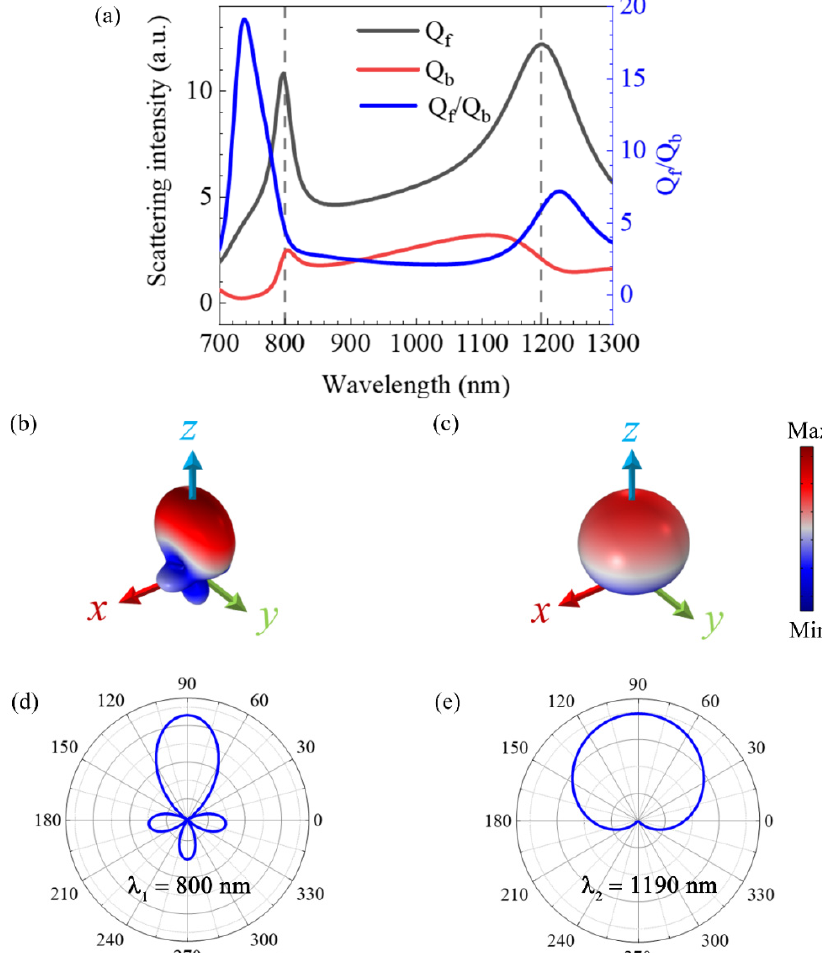
Figure 2. ( a ) Power spectrum of forward scattering ( Q f ), power spectrum of backward scattering ( Q b ) and ratio of intensity of forward and backward scattering ( Q f ⁄ Q b ). Far-field radiation properties for ( b ) λ 1 = 800 nm and ( c ) λ 2 = 1190 nm. Angular plots of far-field radiation ( xoz plane) at ( d ) λ 1 = 800 nm and ( e ) λ 2 = 1190 nm.